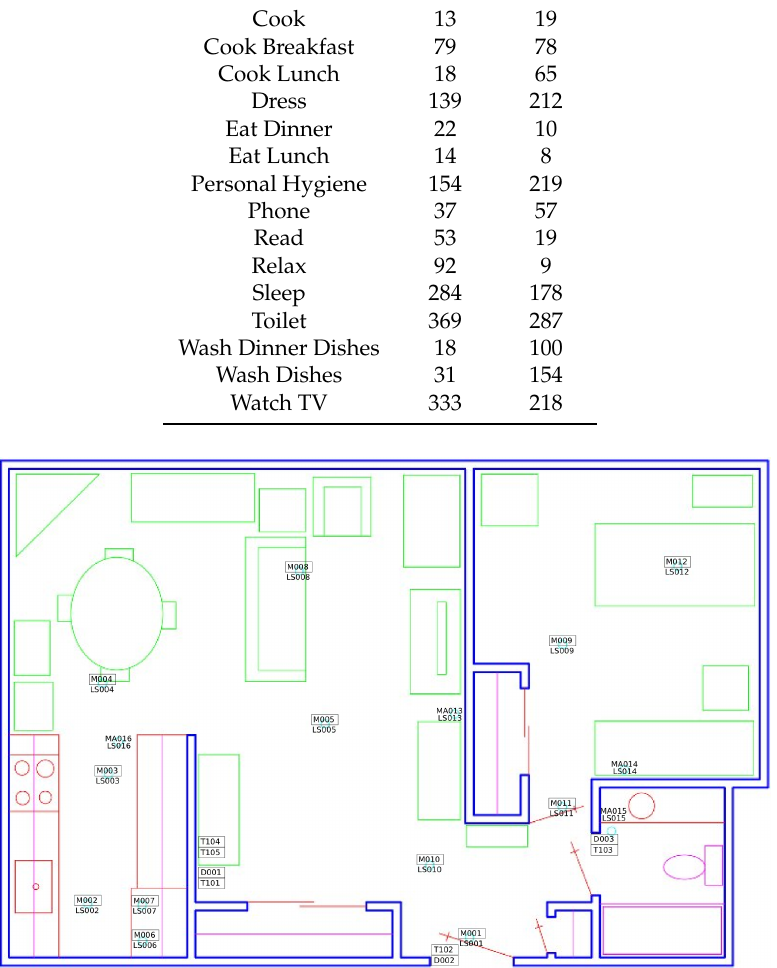
Figure 5. Layout of HH101 apartment. The position of each sensor is specified with the corresponding motion (M), light (LS), door (D), temperature (T), or sensor